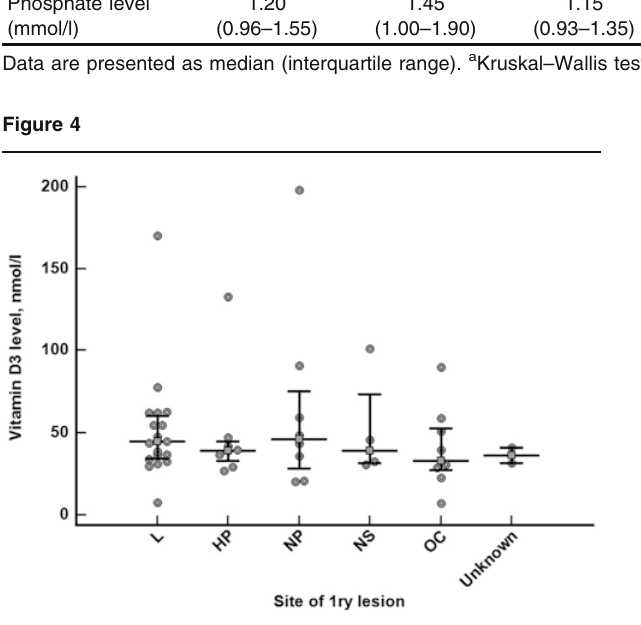
Vitamin D 3 level by site of HNC. Circular markers represent individual observations. Squared marker with traversing horizontal line repre- sents the median (second quartile). Error bars represent the 25th and 75th percentiles (first and third quartiles, respectively). HNC, head and neck cancer; HP, hypopharyngeal; L, laryngeal; NP, nasopha- ryngeal; NS, nasal sinus; OC, oral cavity.